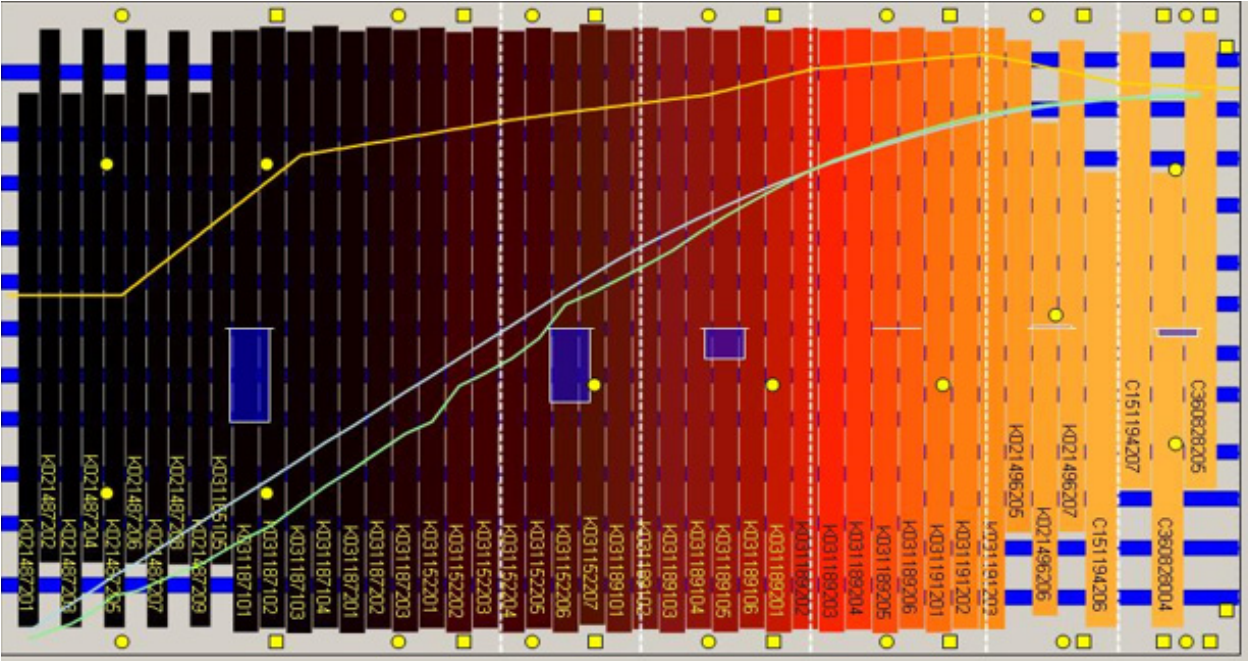
Figure 6. Bake the temperature distribution above and below the batch. Source: own study.